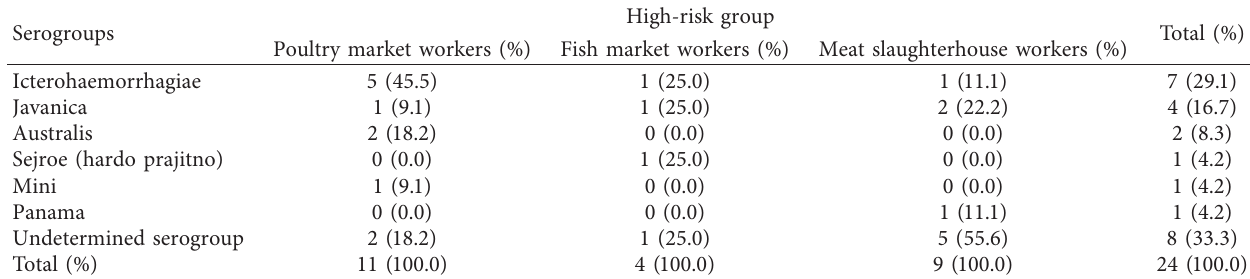
Table 3: Seroprevalence (MAT positivity) of leptospirosis among different occupational groups in Casablanca (Morocco). Occupational groups Table 4: Distribution of different serogroups of leptospira among humans seropositive occupational groups of Casablanca (Morocco). Serogroups